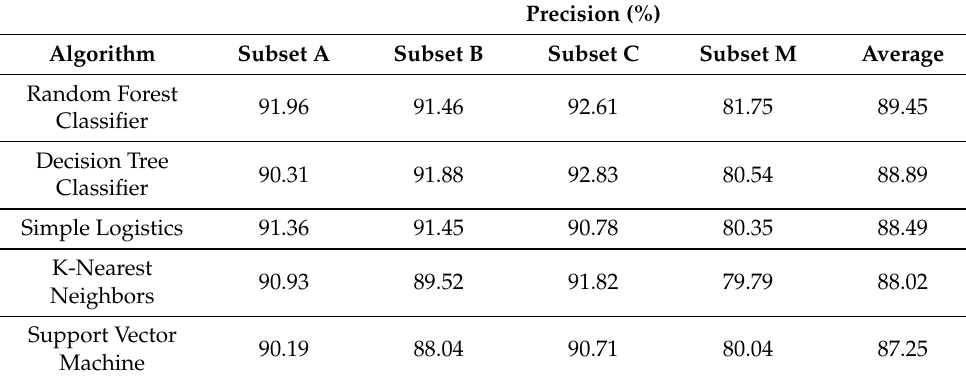
Table 3. Results of the precision of each subset for each tested algorithm.